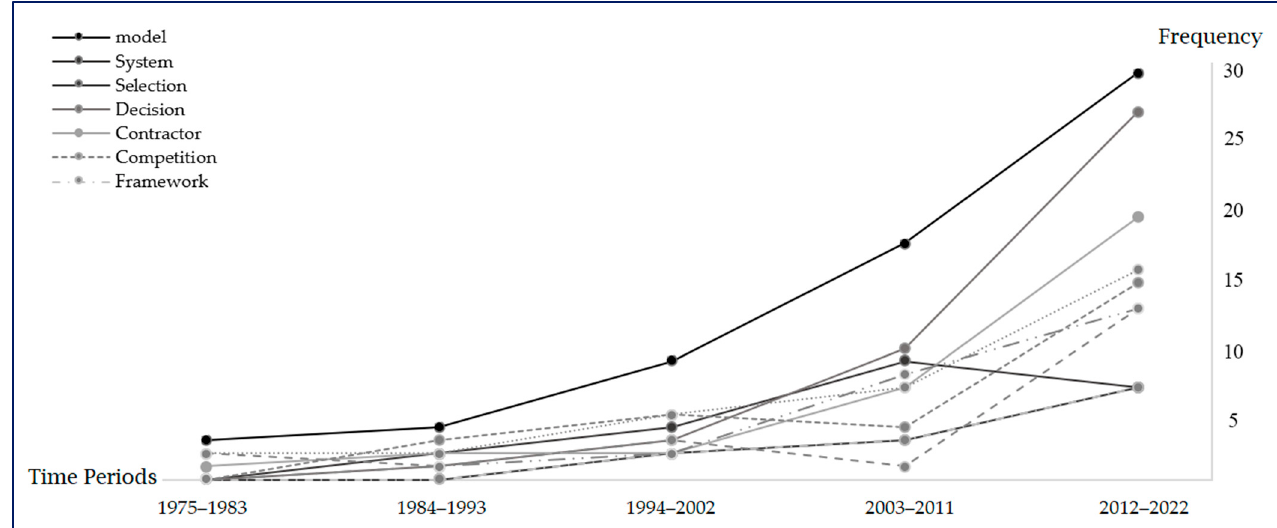
Figure 3. Trends of top 10 keywords’ frequency related to construction bidding (1975–2022).